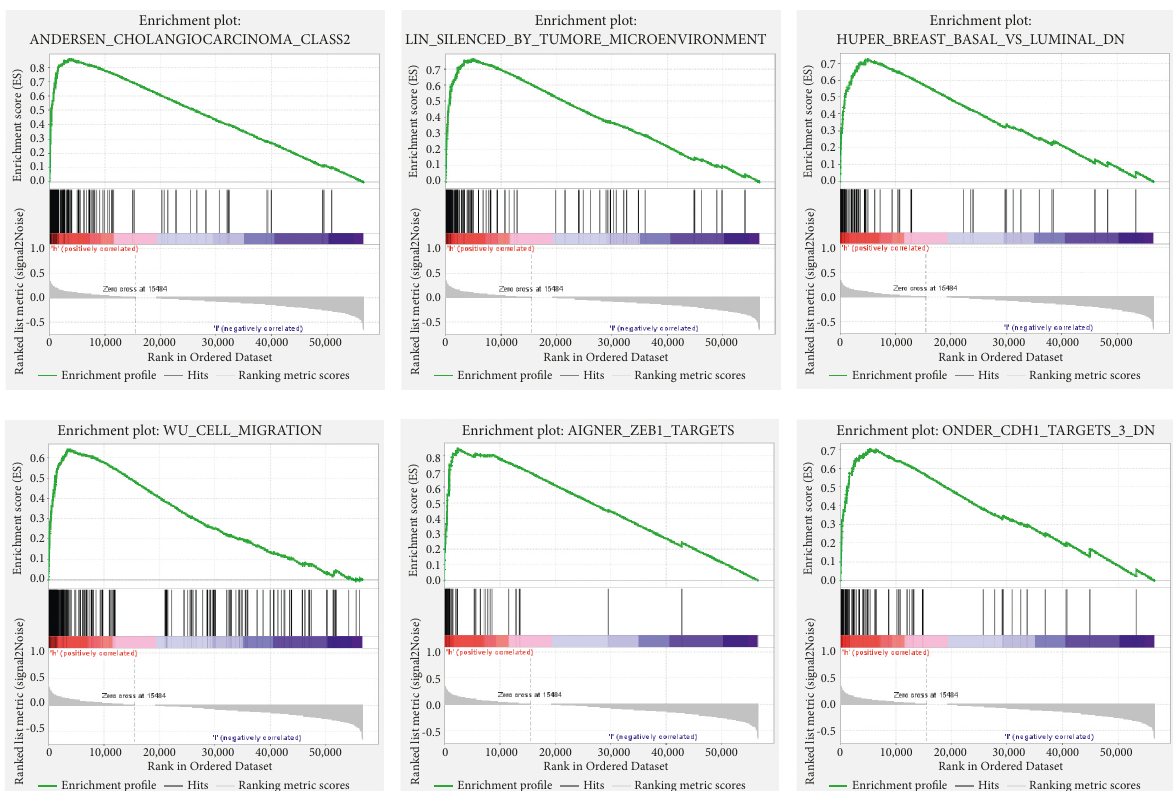
Figure 8: GSEA analysis of deferentially expressed